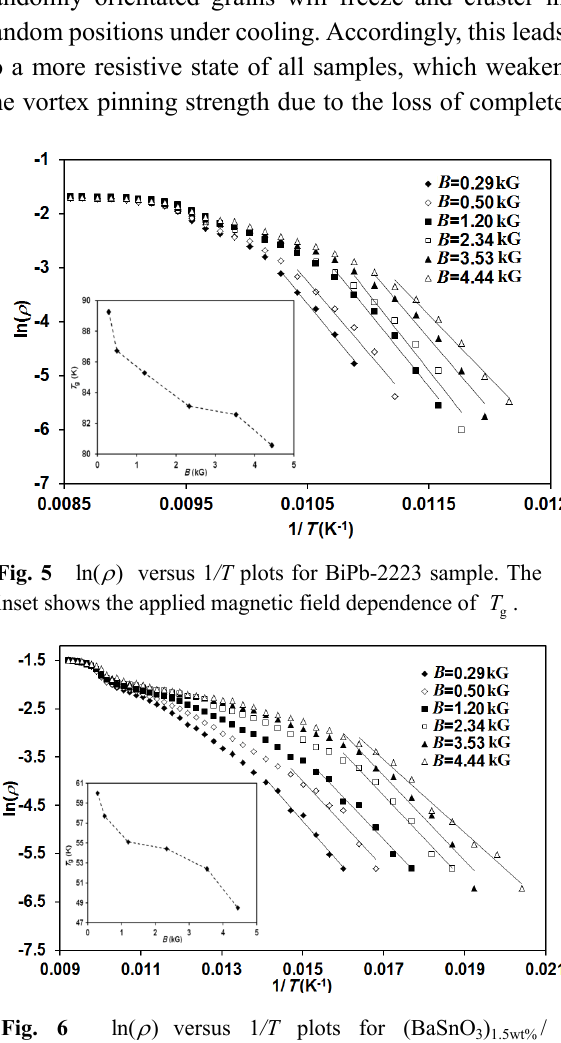
Fig. 6 ln( )  versus 1 /T plots for (BaSnO 3 ) 1.5wt% / BiPb-2223 sample. The inset shows the applied magnetic field dependence of T g